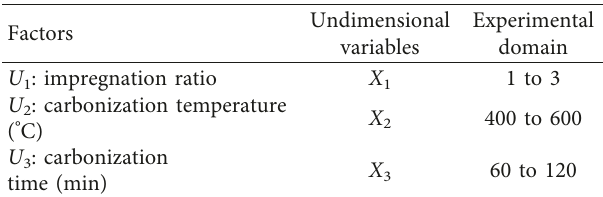
Table 1: Experimental domains for the Doehlert experimental